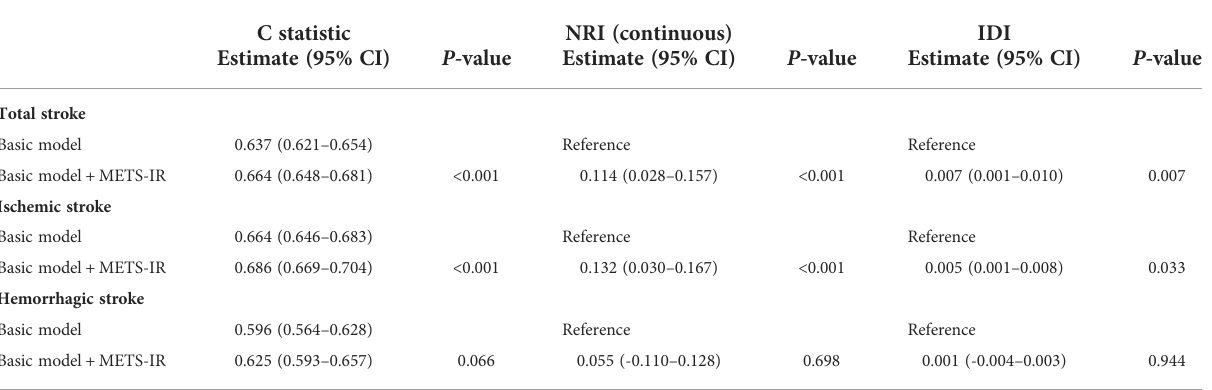
TABLE 3 Incremental predictive value of